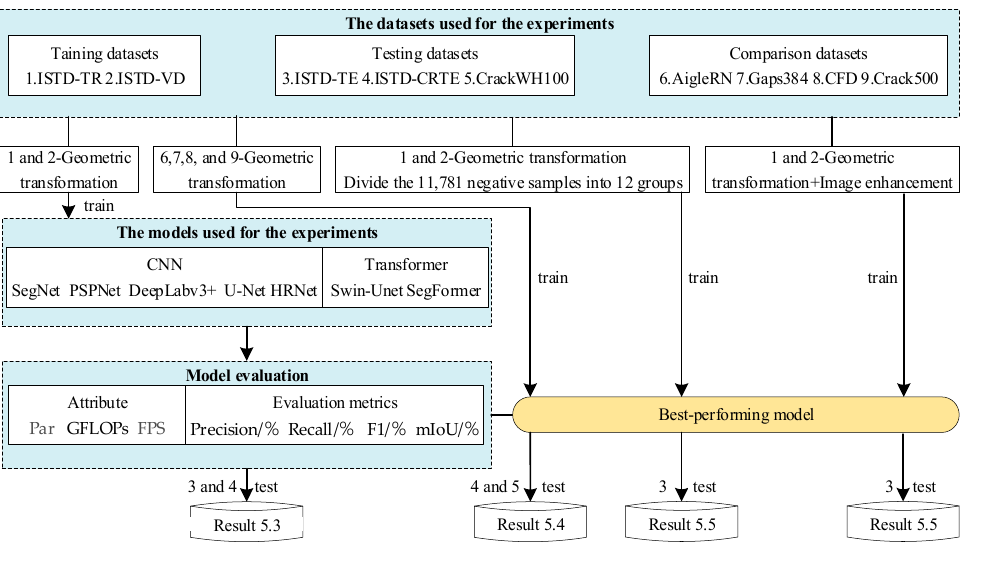
Figure 8. Experimental research fl owchart.